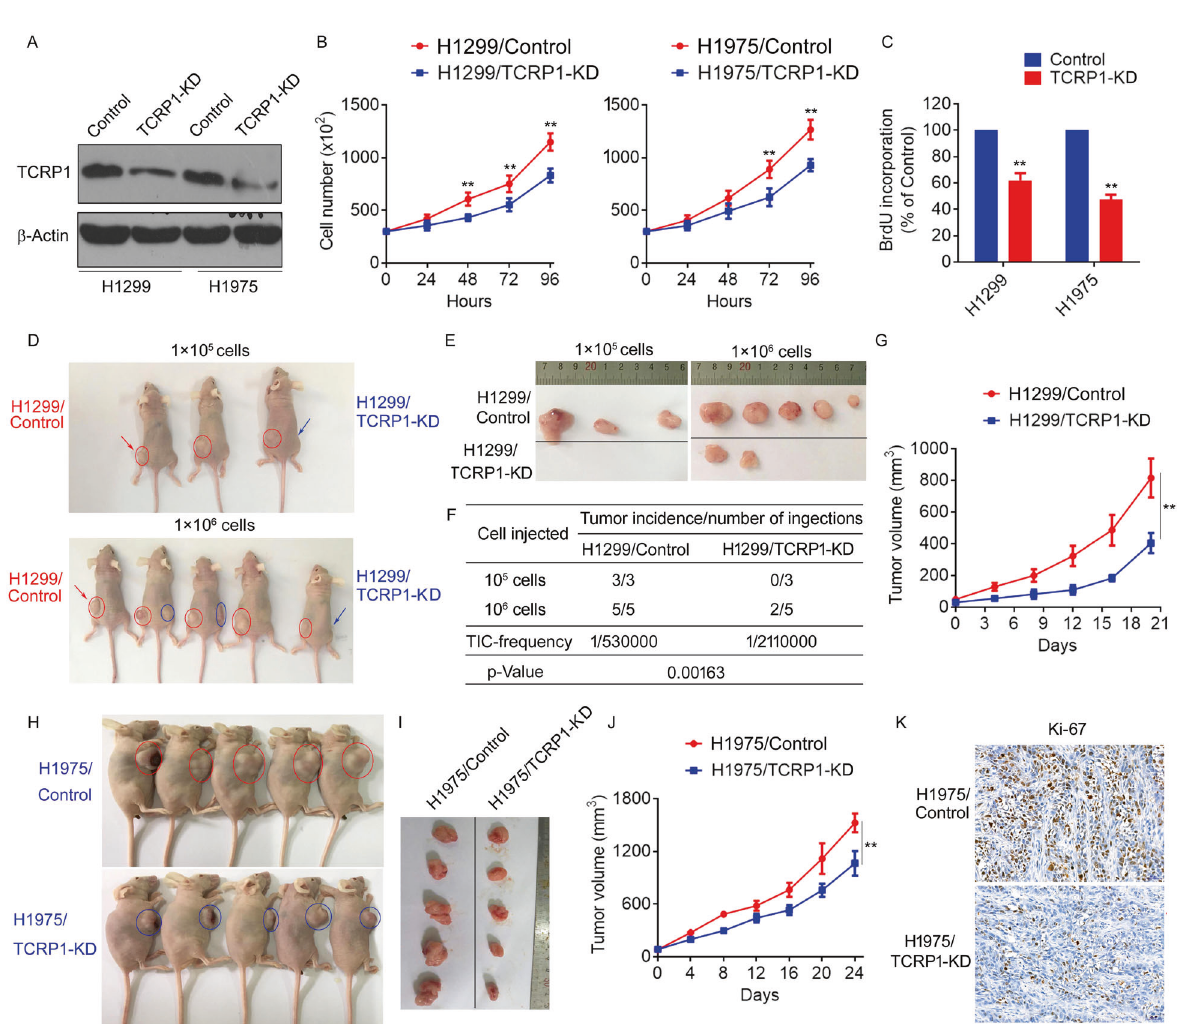
Fig. 3 Knocking down TCRP1 suppressed NSCLC cell proliferation in vitro and in vivo. CRISPR-CAS9 technique was used to knock down TCRP1 in H1299 and H1975 cells. Protein expression of TCRP1 in mentioned cells was measured via western blot assay ( A ). The proliferation of above cells was evaluated by cell viability ( B ) and BrdU assays ( C ), vs Control, ** P < 0.01. ( D ) A total of 1 × 10 5 and 1 × 10 6 mentioned cells were subcutaneously injected into nude mice, respectively. The H1299/Control cells were injected at left, while the H1299/TCRP1 KD cells were injected at right. The tumors obtained from these mice were exhibited ( E ), the tumor incidence ( F ) and tumor growth curve were analyzed, vs Control, ** P < 0.01 ( G ). The H1975/Control cells were subcutaneously injected at left of nude mice, while the H1975/TCRP1 KD cells were at right. The tumors obtained from these mice were exhibited ( H ). The tumor growth curves were plotted using average tumor volume within each experimental group at the set time points ( I ). ( J ) IHC assays were performed to determine ki67 expression level in these tumors. vs Control, ** P < 0.01. ( K ) Ki-67 expression in tumors of H1975/Control and H1975/TCRP1 KD group were evaluated by IHC assays. to the TCRP1 promoter at both sites in A549 cells. While the type p53 signi fi cantly suppressed TCRP1 expression in both H1299 mutant p53 in H1975 cells did not (Fig. 2D). Additionally, we and H1975 cells. However, this effect would be reversed by conducted luciferase reporter assays in H1299 and H1975 cells overexpression of p53 mutants (Fig. 2B). Consistently, depletion of with wild-type and mutant p53, respectively. The data demon- wild-type p53 using small interfering RNA (shRNA) signi fi cantly strated that wild-type p53 could signi fi cantly suppress the activity increased the expression of TCRP1 in A549 cells (Fig. S1B, Fig. 2C). of wild-type TCRP1 promoter in H1299 and H1975 cells. The Furthermore, CHIP assays suggested that wild-type p53 could bind Oncogenesis (2022)